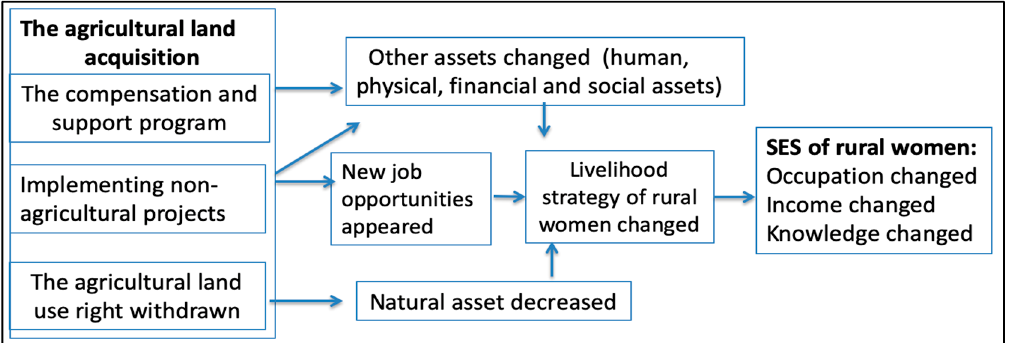
Figure 1. Conceptual framework. SES: socioeconomic status.